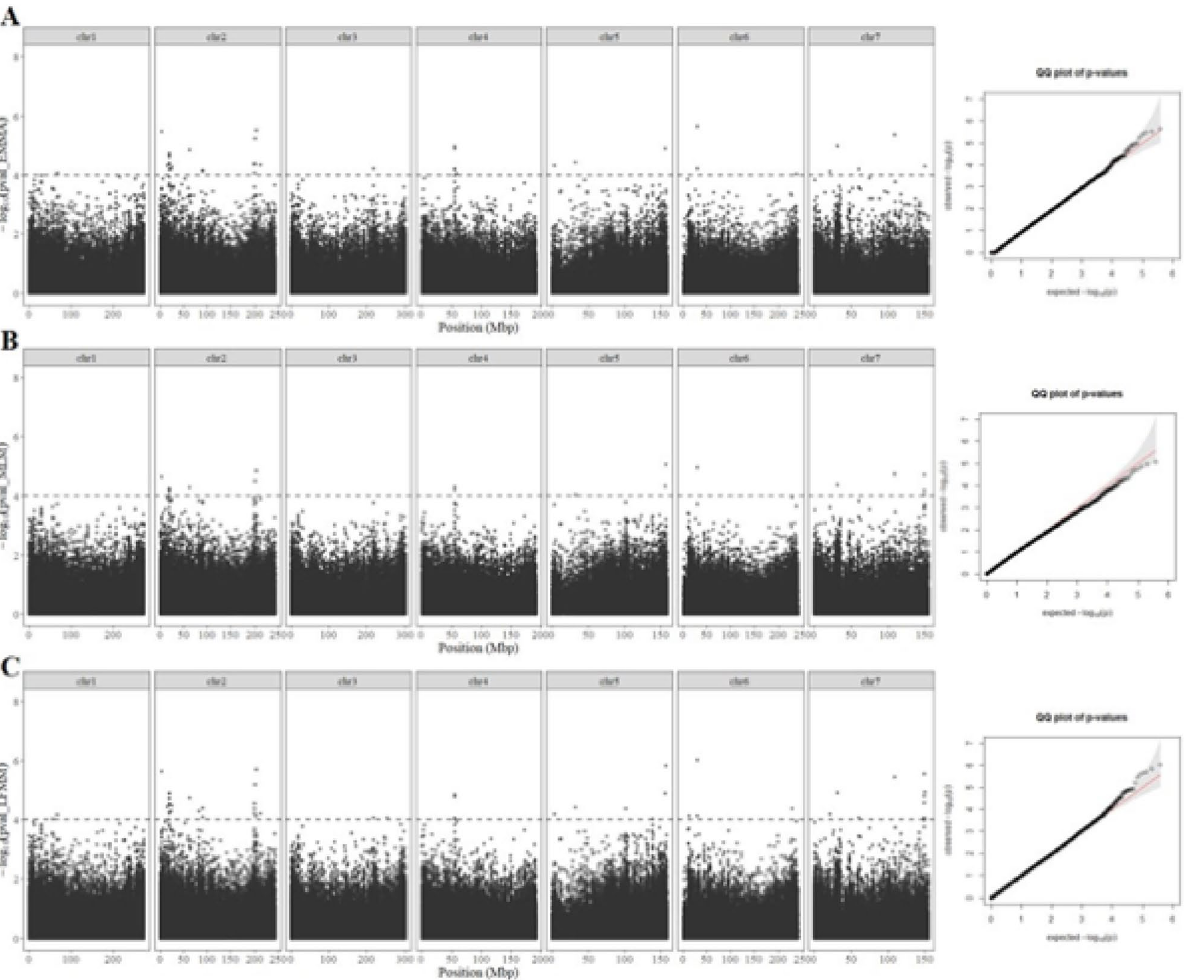
Figure 2. Genome-wide association studies (GWAS) for rhizosheath size in pearl millet. Manhattan plots and QQ plots obtained with three GWAS methods. ( A ) Efficient Mixed Model Association or EMMA, ( B ) Mixed linear model or MLM and ( C ) Latent Factor Mixed Model or LFMM. Each Manhattan plot shows the –log10 p value of the statistic (y axes) for each SNP position (x axes). The dashed line delimits the threshold for highly significant SNPs ( p value < 10 –4